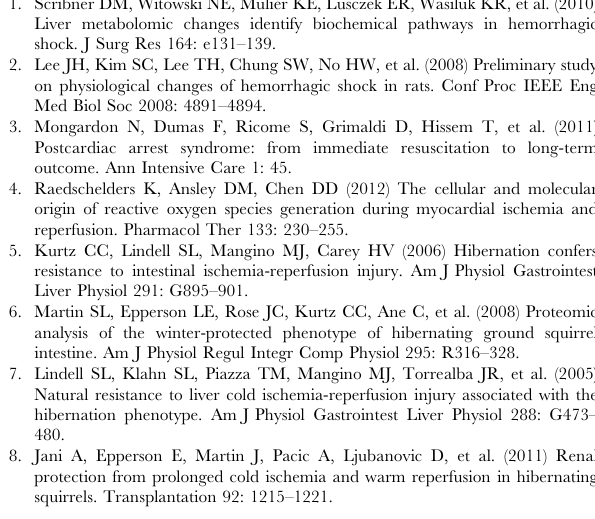
Figure S11 Example Jres NMR spectrum from unpro- cessed AGS plasma. (TIF) Figure S12 Hydrophilic metabolic profiles for naı¨ve, before SHS, after SHS, before HS, and after HS rats (A; R 2 = 0.75, Q 2 = 0.15, permutation p= 0.90) summer eu- thermic AGS (B; R 2 = 0.60, Q 2 =0.07, permutation p =0.03) and winter IBA-AGS (C; R 2 = 0.90, Q 2 =0.30, permutation p= 0.38). Table S1 Experimental groups HS experiments. Table S2 Characteristics of AGS undergoing HS during the winter (IBA) season. Table S3 Characteristics of AGS undergoing HS during the summer (euthermic) season. Table S4 Characteristics of AGS undergoing SHS dur- ing the winter (IBA) season. Table S5 Characteristics of AGS undergoing SHS dur- ing the summer (euthermic)